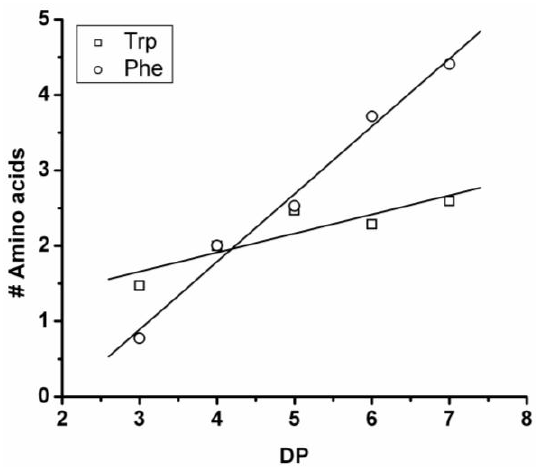
Figure 13. Average amount of amino acids in poly(Trp-co-Phe) for every observed